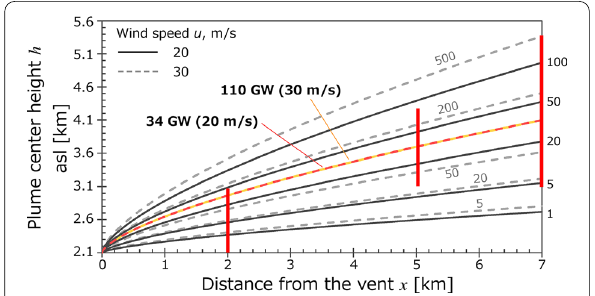
Fig. 8 Tracks of the ash cloud. Red bars represent ash height detected by the Nagano weather radar (blue circle in Fig. 1a) at 2, 5, and 7 km from the MC at 10:05–10:10 (JST) (Meteorological Research Institute 2018). Geometries of a buoyant plume were calculated with Eq. 1 and 2, assuming a wind speed of 20 m/s (solid lines) and 30 m/s (dashed lines). Values in the figure indicate the heat discharge rate ˙ q in GW (10 9 W), as defined in Eq. (2). The source of the plume is fixed to the location of the